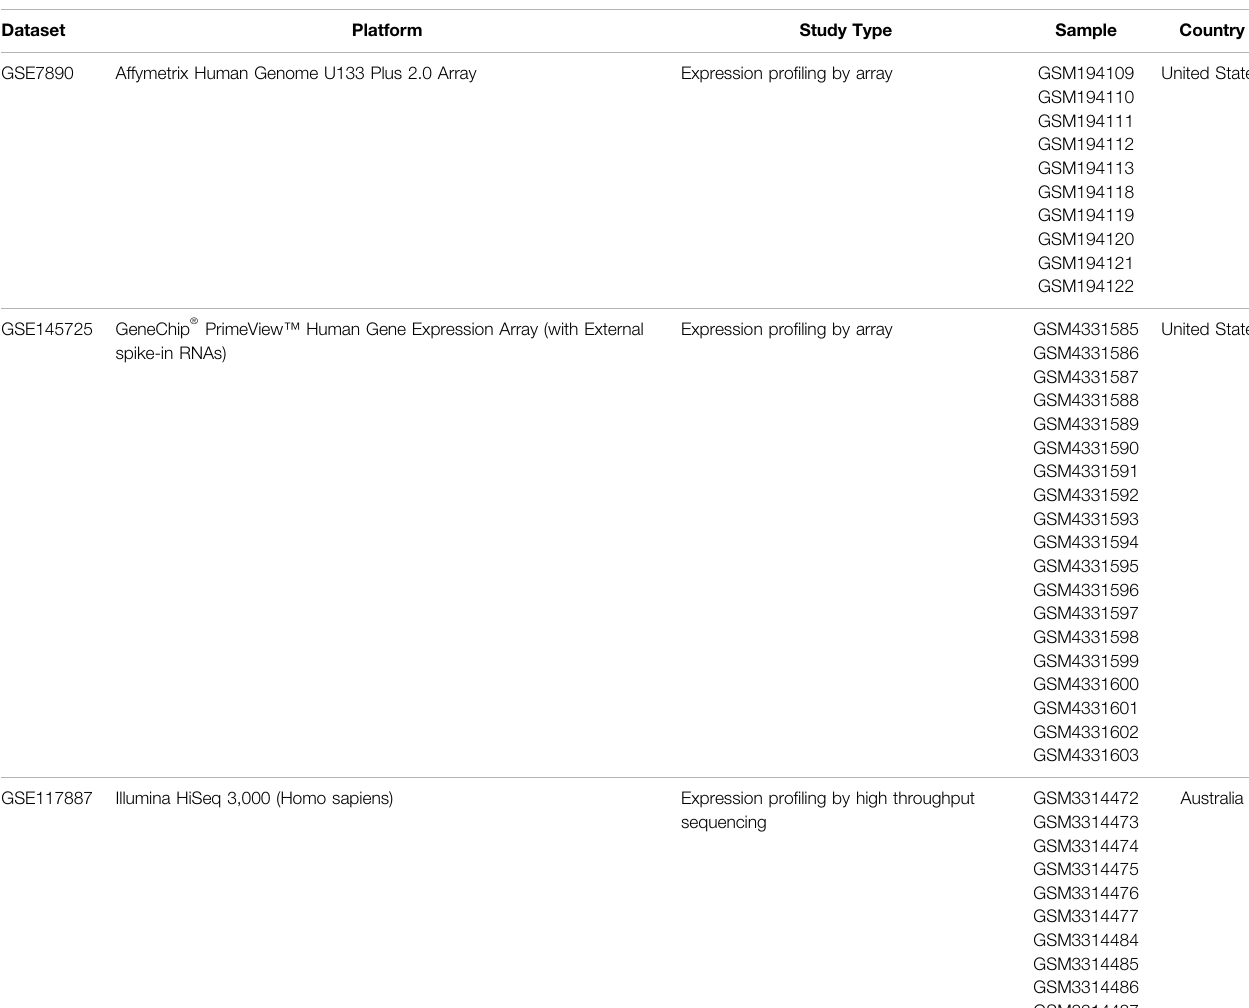
TABLE 1 | Overview of the datasets used in this study.